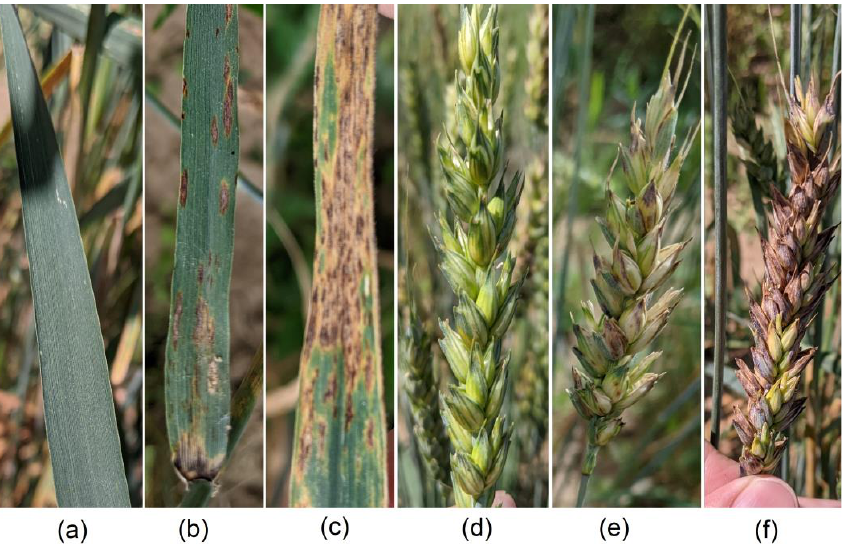
Figure 1. The degrees of septoriosis disease severity on spring wheat leaves and ears: ( a ) healthy leaf; ( b ) medium lesion on leaf; ( c ) severe lesion on leaf; ( d ) healthy ear; ( e ) medium lesion on ear; ( f ) severe lesion on ear.